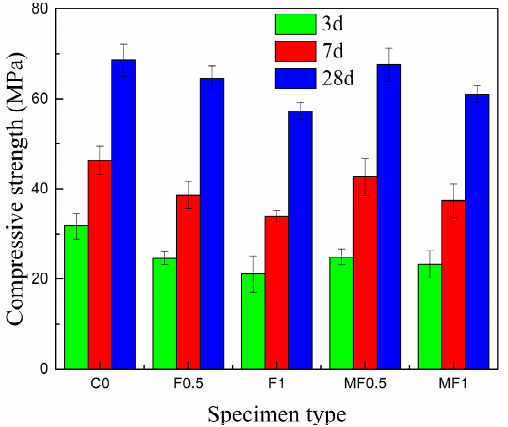
Figure 6. Compressive strength of cement specimens for different curing ages.